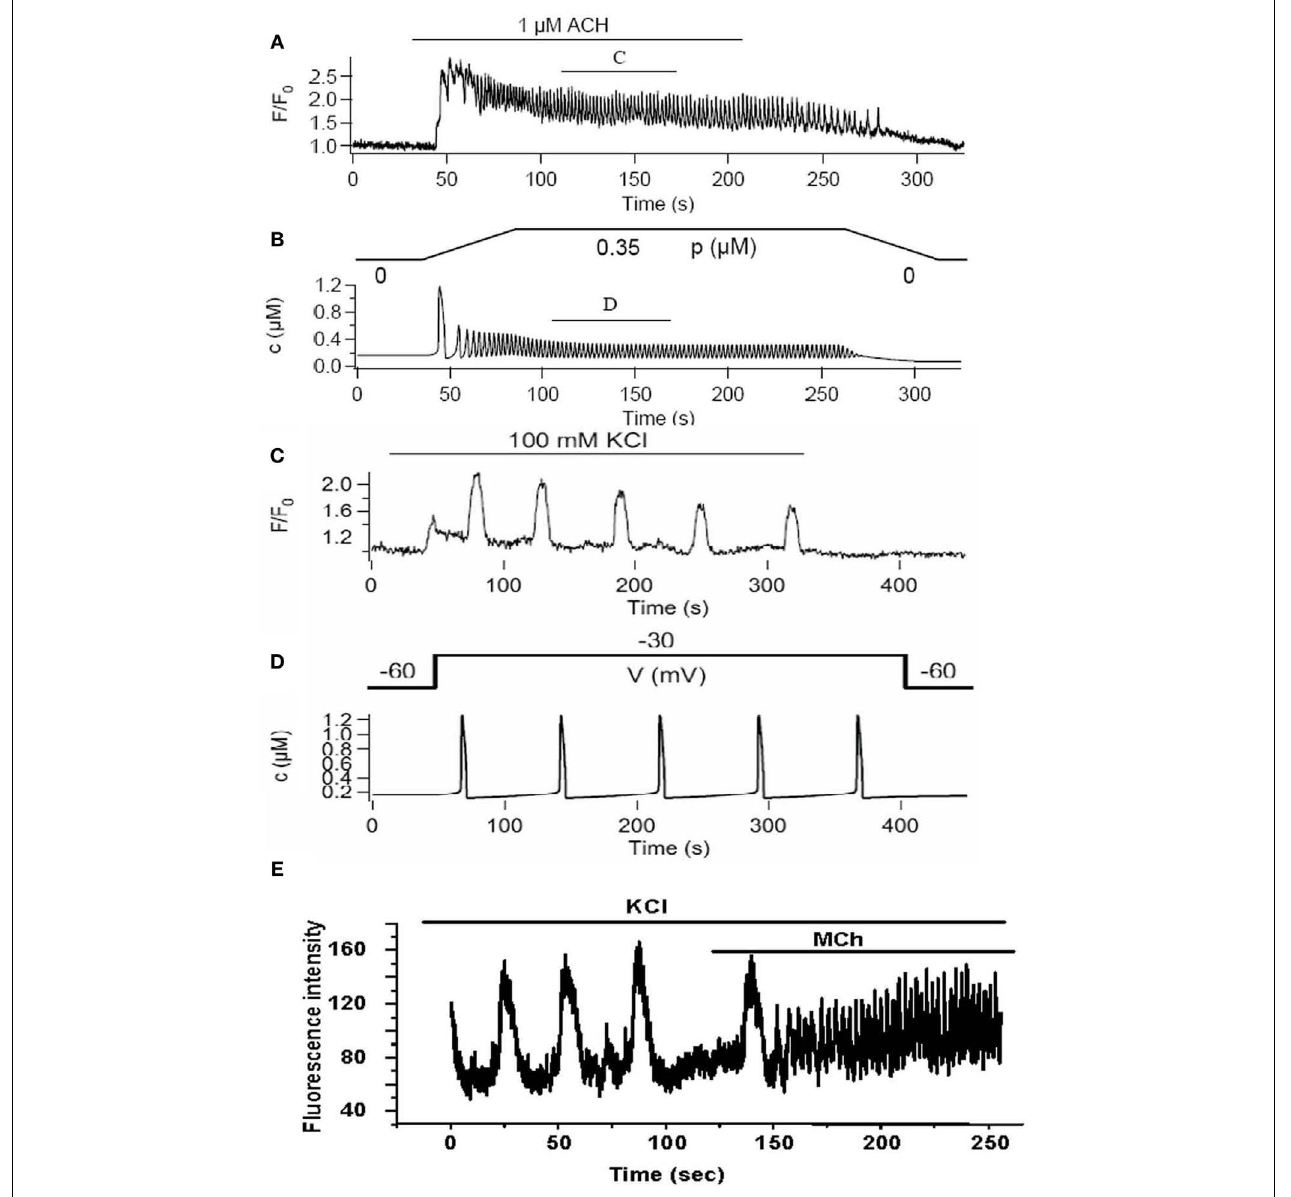
FIGURE 8 |A comparison of experimental and model Ca 2 + oscillations induced by agonist (A,B) and KCl (C,D). Agonist-induced Ca 2 + oscillations are fast compared to KCl-induced Ca 2 + oscillations. (E)